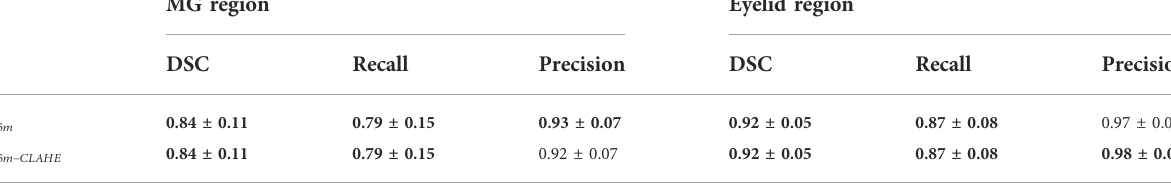
TABLE 2 Segmentation results of testing images from K5M.